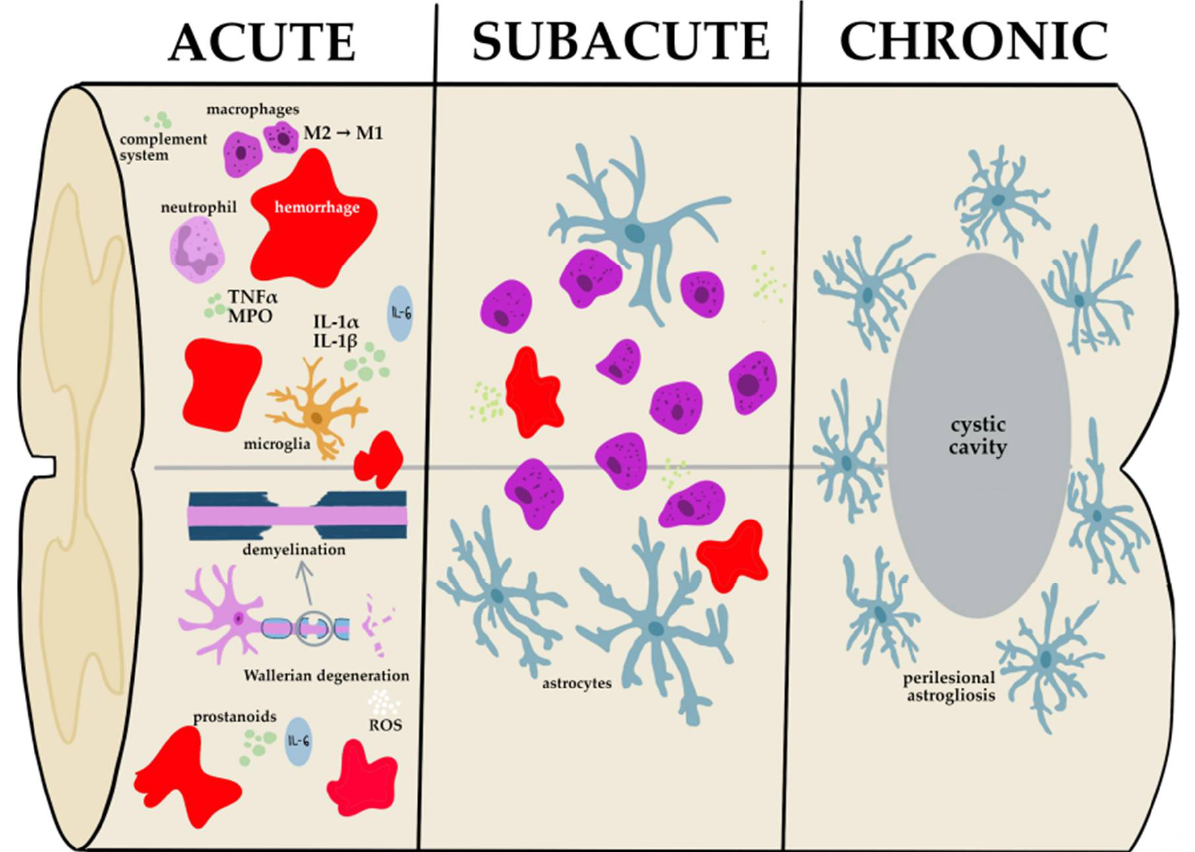
Figure 2. Graphical presentation of the course of SCI secondary stage at the cellular level. Phenomena present in acute SCI (2–48 h): ischemia, mitochondrial failure, ionic imbalance, ROS production, inflammatory processes, Wallerian degeneration, demyelination, glutamate toxicity, debris phago- cytosis by macrophages; subacute SCI (2 days–2 weeks): glial scar formation by astrocytes, further debris phagocitosis; chronic SCI (>2 weeks): glial scar maturation, cyst formation, axonal